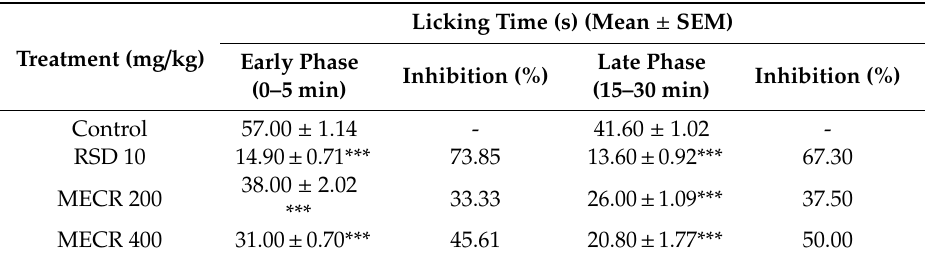
Table 1. Anti-nociceptive e ff ect of MECR in formalin induced paw licking test in mice.